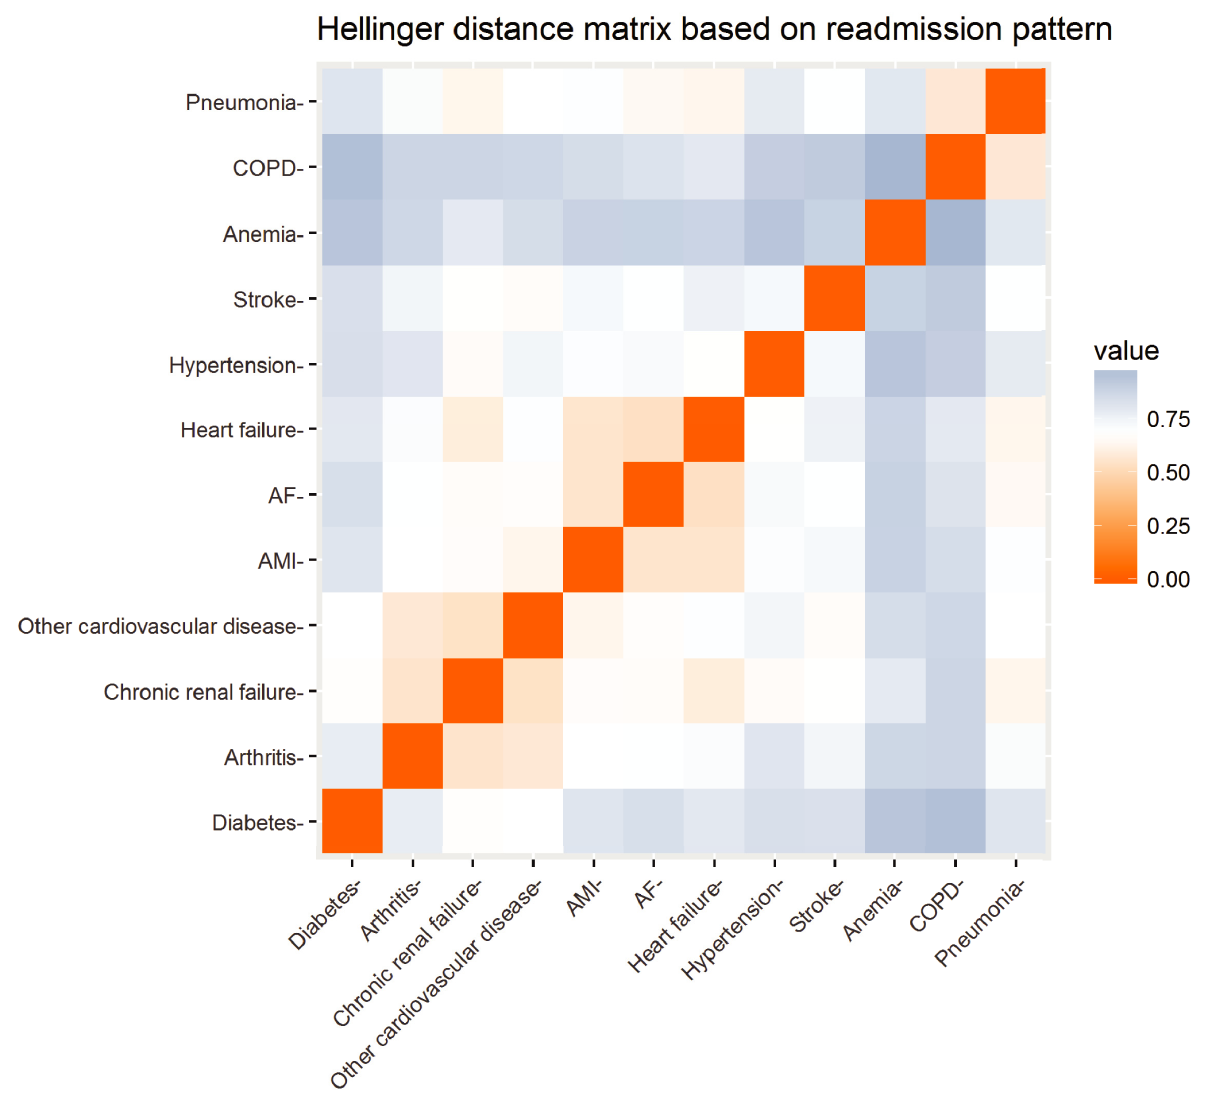
Fig 6. Readmission pattern for each of the chronic conditions (Hellinger distance matrix). Abbreviations: AF atrial fibrillation; AMI acute myocardial infarction; COPD chronic obstructive pulmonary disease.